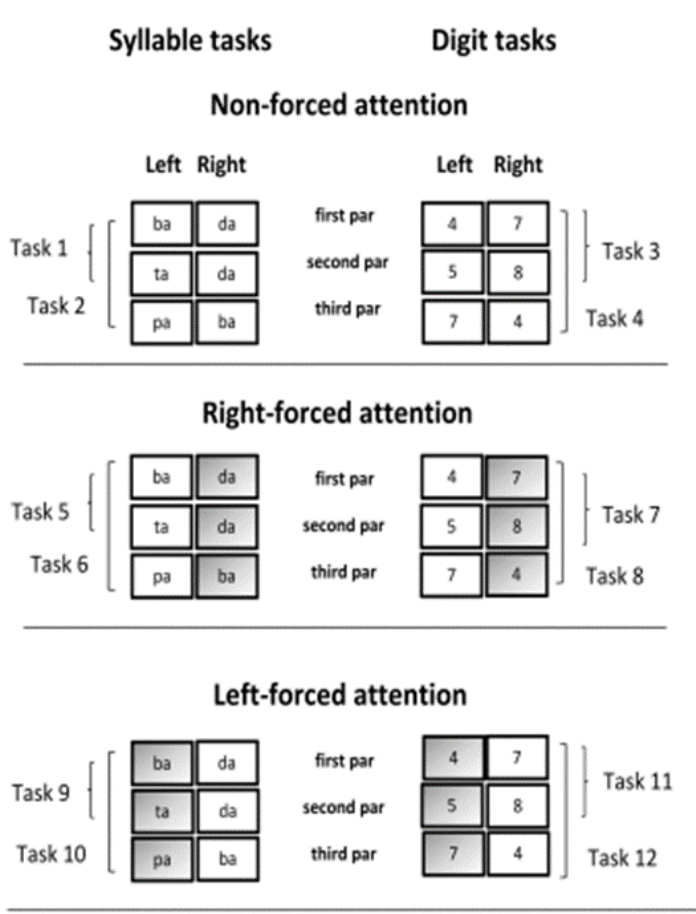
Figure 1. Characteristics of the 12 DL tasks applied.